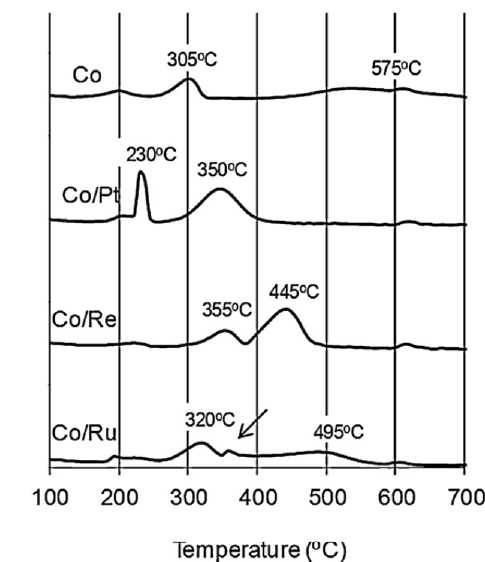
Figure 2. TPR profiles by Cook et al. [9] show that Pt and Re are more efficient than Ru in facilitating reduction of cobalt oxides over 25%Co/ γ -Al atomic loading ( i.e. , noble metal / Co ratio was